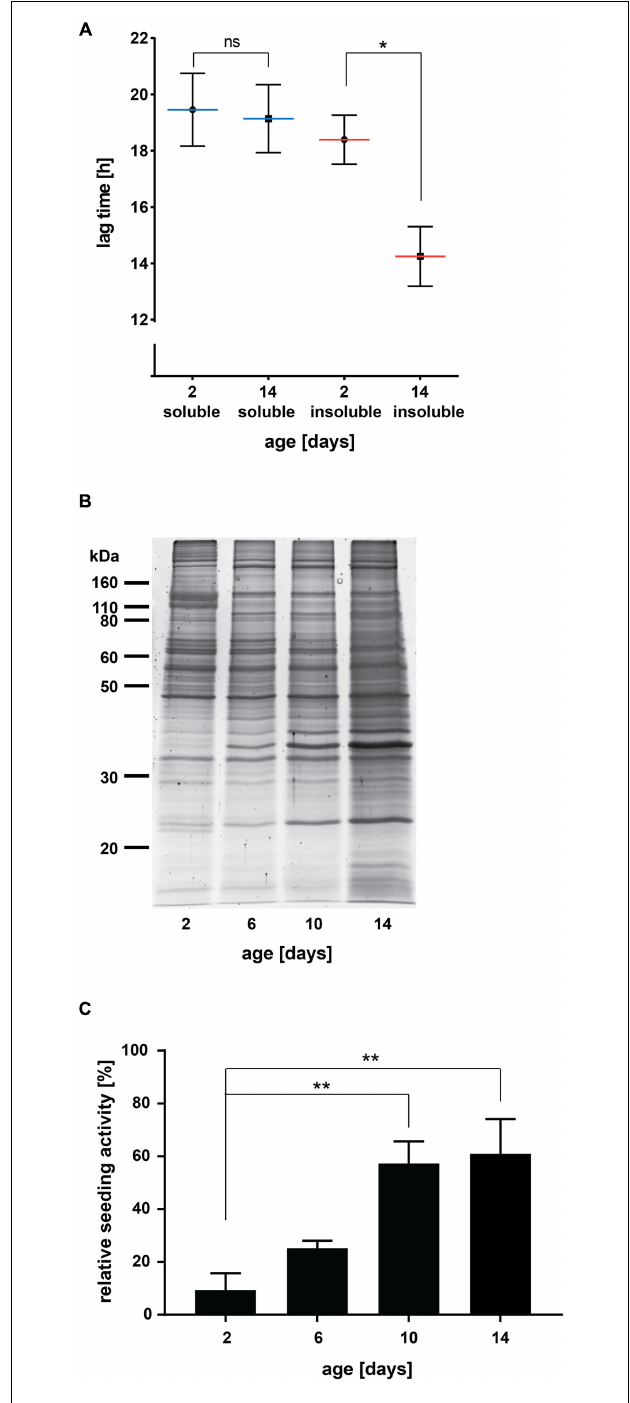
FIGURE 1 | Insoluble protein extracts from aged C. elegans seed A β aggregation in vitro . (A) Lag times measured for A β aggregation in the presence of 0.001 µ g C. elegans soluble and detergent-insoluble protein extracts (day 2 and day 14). Mean values (blue lines soluble, red lines insoluble) with respective SEM of three biological replicates are represented (each including a minimum of five technical replicates). Two-tailed p -value: day 2 insoluble vs. day 14 insoluble ∗ p = 0.039. (B) SDS gel of insoluble protein ( Continued )